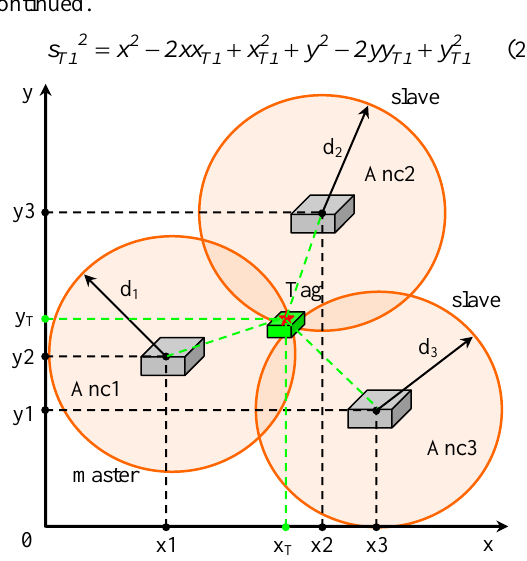
Figure 2. The positioning method between anchors and tags.